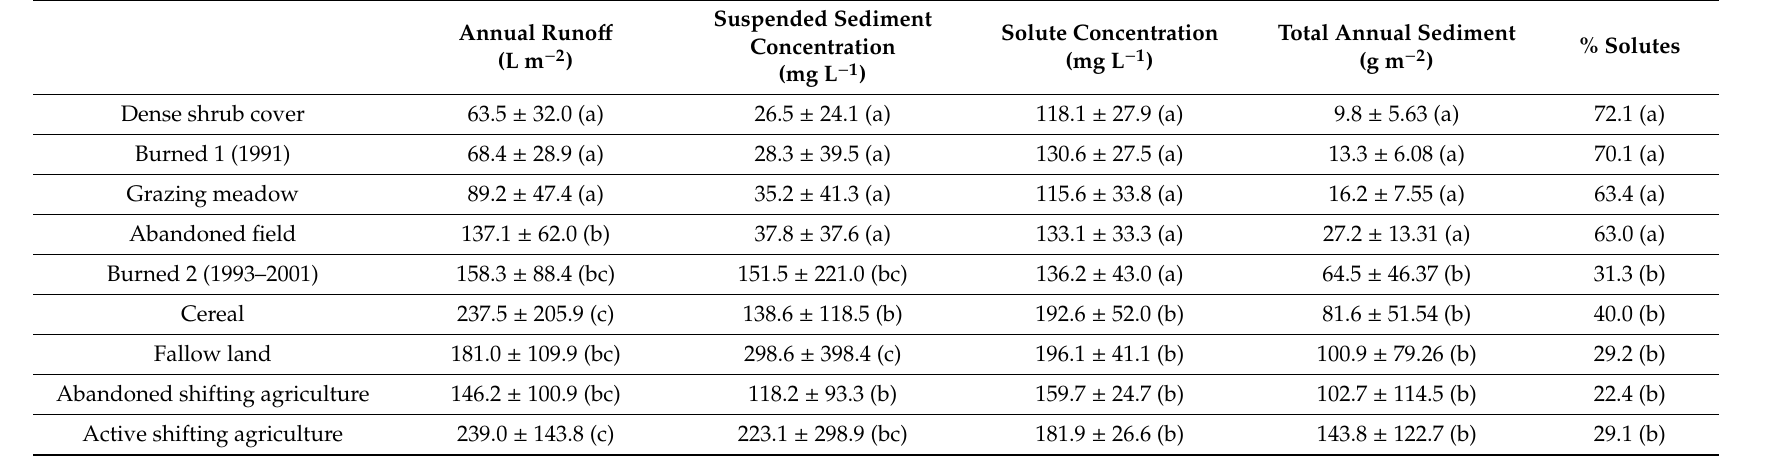
Table 2. Mean values and standard deviations of runo ff , suspended sediment concentration, solute concentration, total sediment and % of solutes for the period of 1991–2011 (except for abandoned field whose data are from 1992–2011, burned 2 whose data are from 1993–2011 and abandoned shifting agriculture whose data are from 1995–2011). Means with the di ff erent lower-case letter within a column are significantly di ff erent at the 0.05 level of significance ( p <